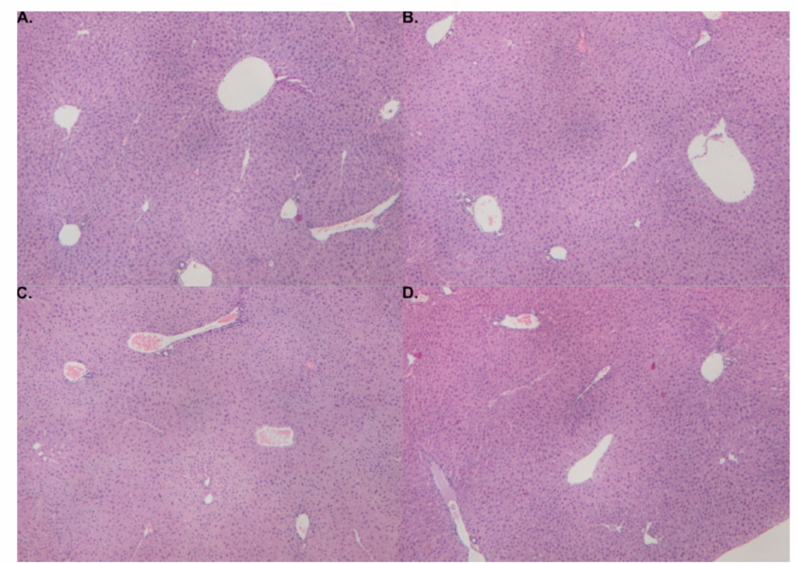
Figure 2. E ff ects of MSM, CRCE, or MSM / CRCE on liver morphology. ( A ) vehicle (sesame oil); ( B ) MSM; ( C ) CRCE; ( D ) MSM / CRCE. Magnification: × 40. MSM—methylsulfonylmethane, CRCE—cannabidiol-rich cannabis